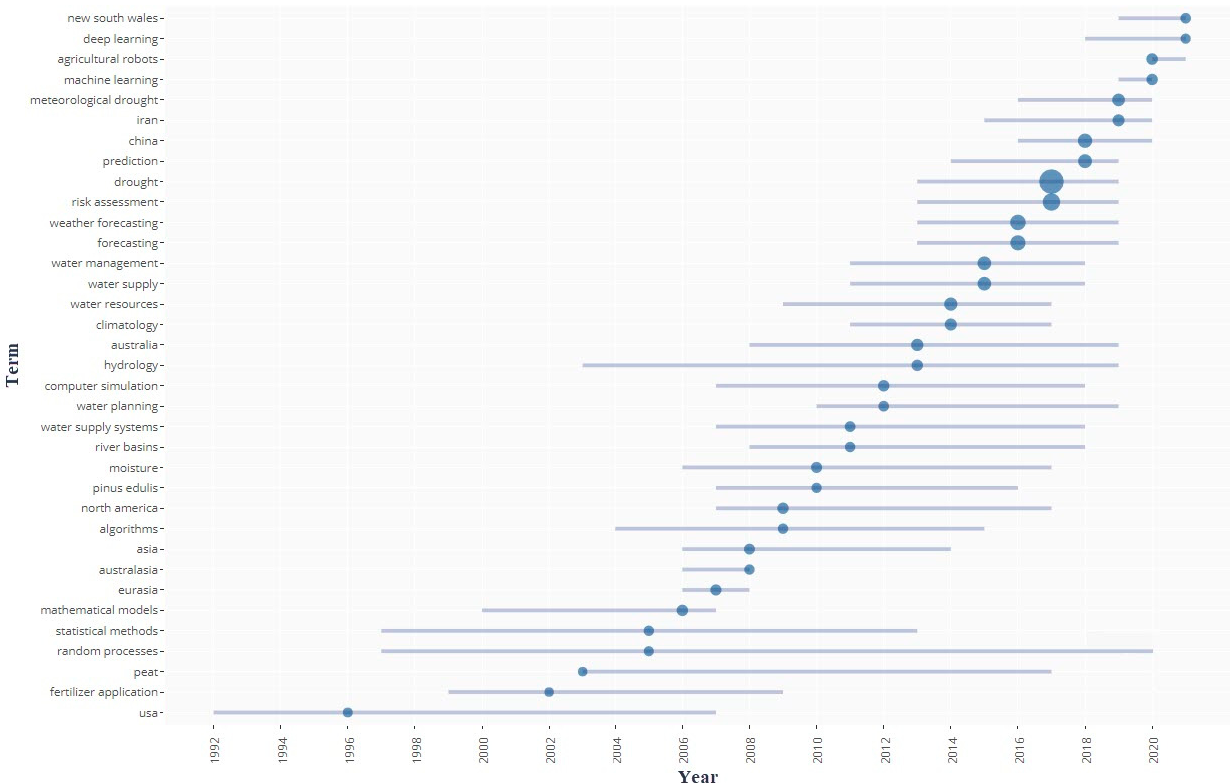
Figure 15. Trend topics on DR_DF-related studies in terms of keywords plus.